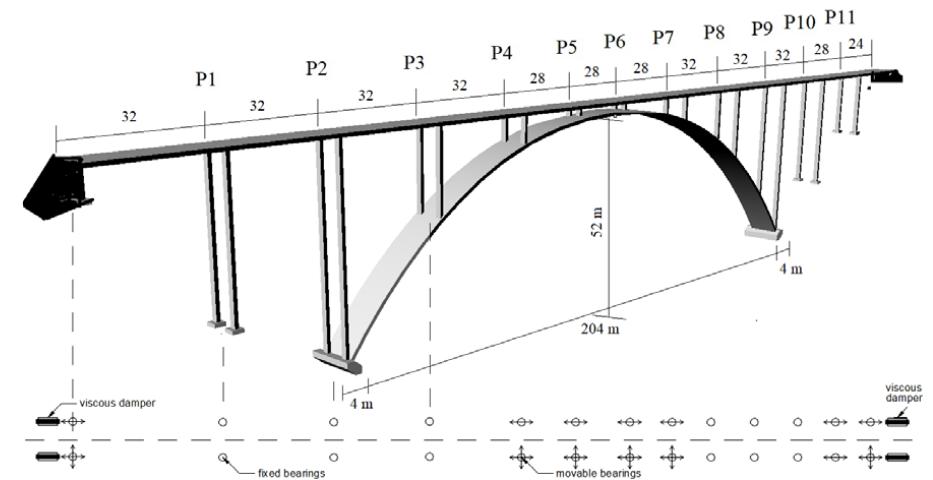
Figure 1. Longitudinal view of the model RC arch bridge designed for this study. All measurements are in m.